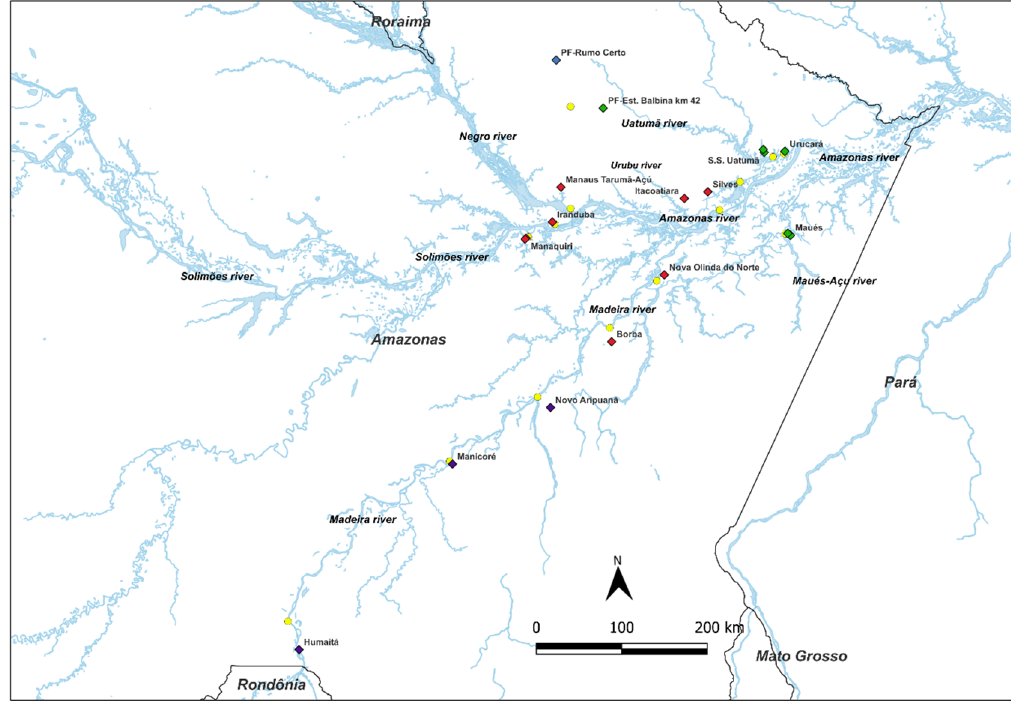
Figure 1. Geographical representation of the genetic composition of 228 plants of A. aculeatum used by extractive producers in 15 populations distributed in 14 municipalities in the state of Amazonas, estimated with the Structure program from ten microsatellite loci. Each color in the square symbol represents a grouping determined from the estimates q K obtained from each evaluated plant. Map plotted with DIVA-GIS, version 7.5.